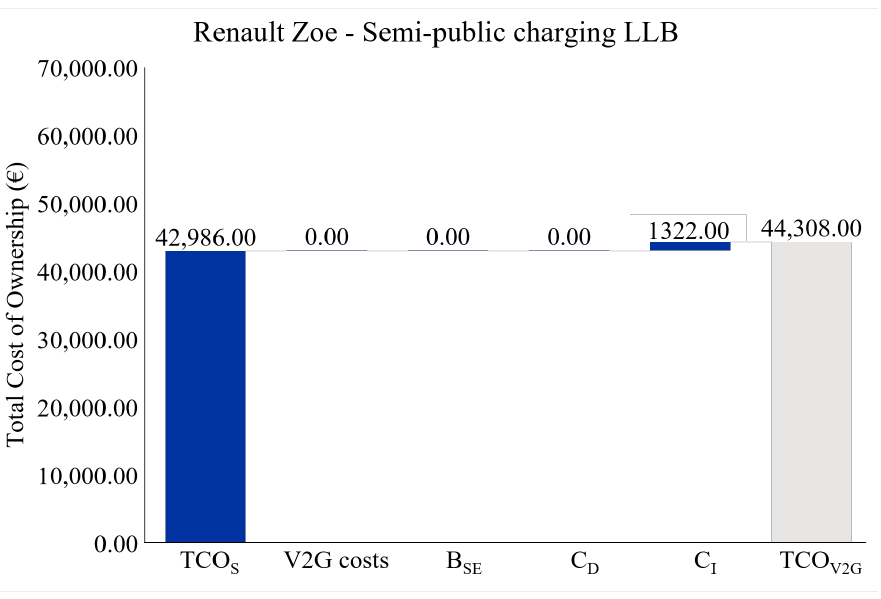
Figure A3. Standard and V2G TCO of a Renault Zoe in a semi-public charging case providing LLB ( TCO S = Standard TCO, B SE = benefit of saved electricity costs from the grid, C D = direct compensation, C I = indirect compensation, TCO V 2 G = V2G TCO); source: own